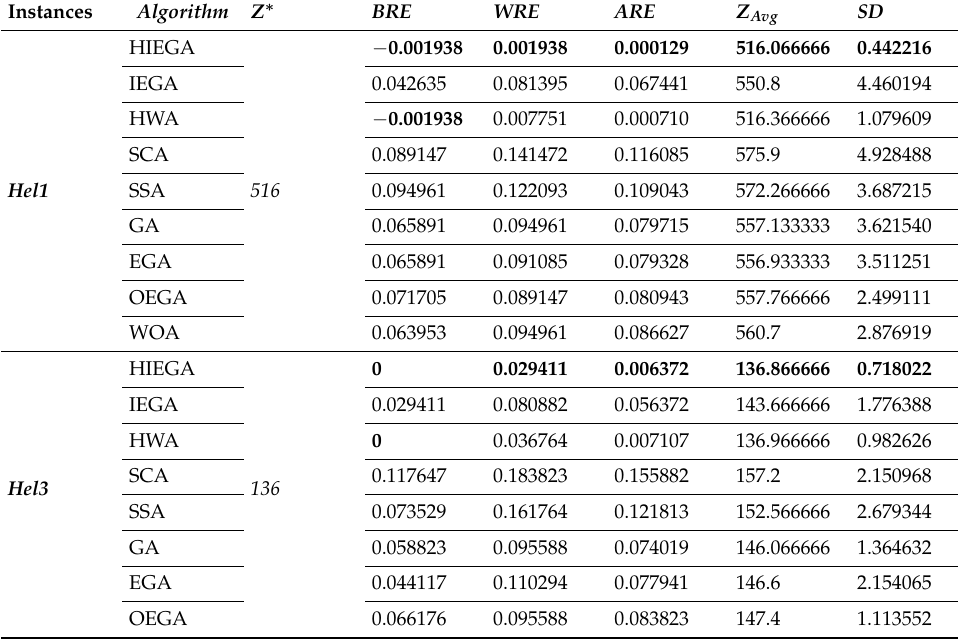
Bold values indicate the best